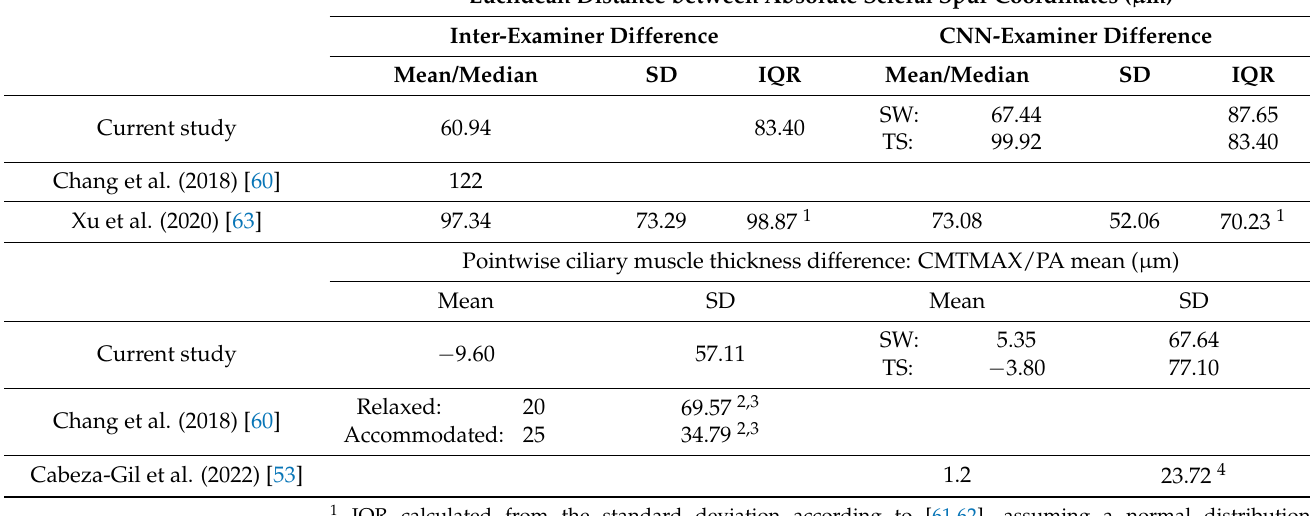
Table 5. Overview of inter-examiner and CNN-examiner differences between absolute coordinates of the scleral spur and the biometric parameter ciliary muscle thickness (CMTMAX, PA) derived from segmented OCT images as reported by different